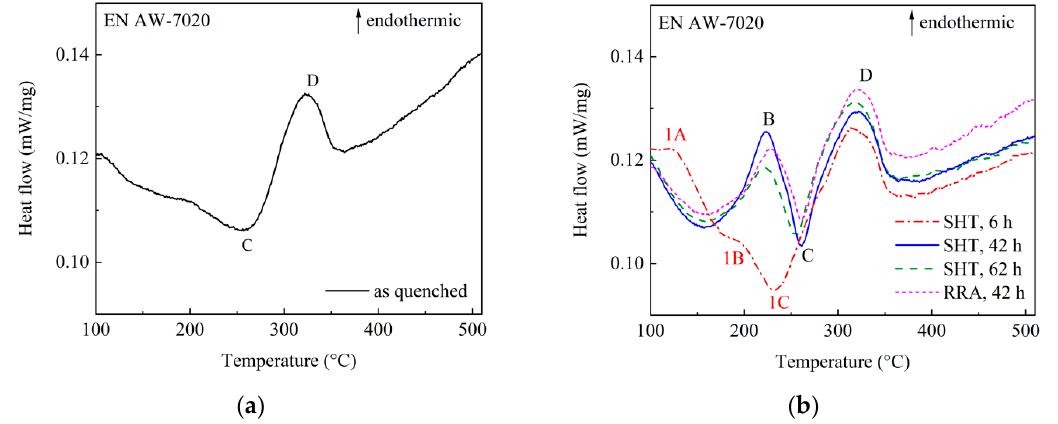
Figure 6. DSC curves for the alloy EN AW-7020 performed with a heating rate of 10 K/min. ( a ) Immediately after SHT and quenching, ( b ) at intermediate stages of artificial aging after solution heat treatment (SHT) or retrogression and re-aging (RRA).